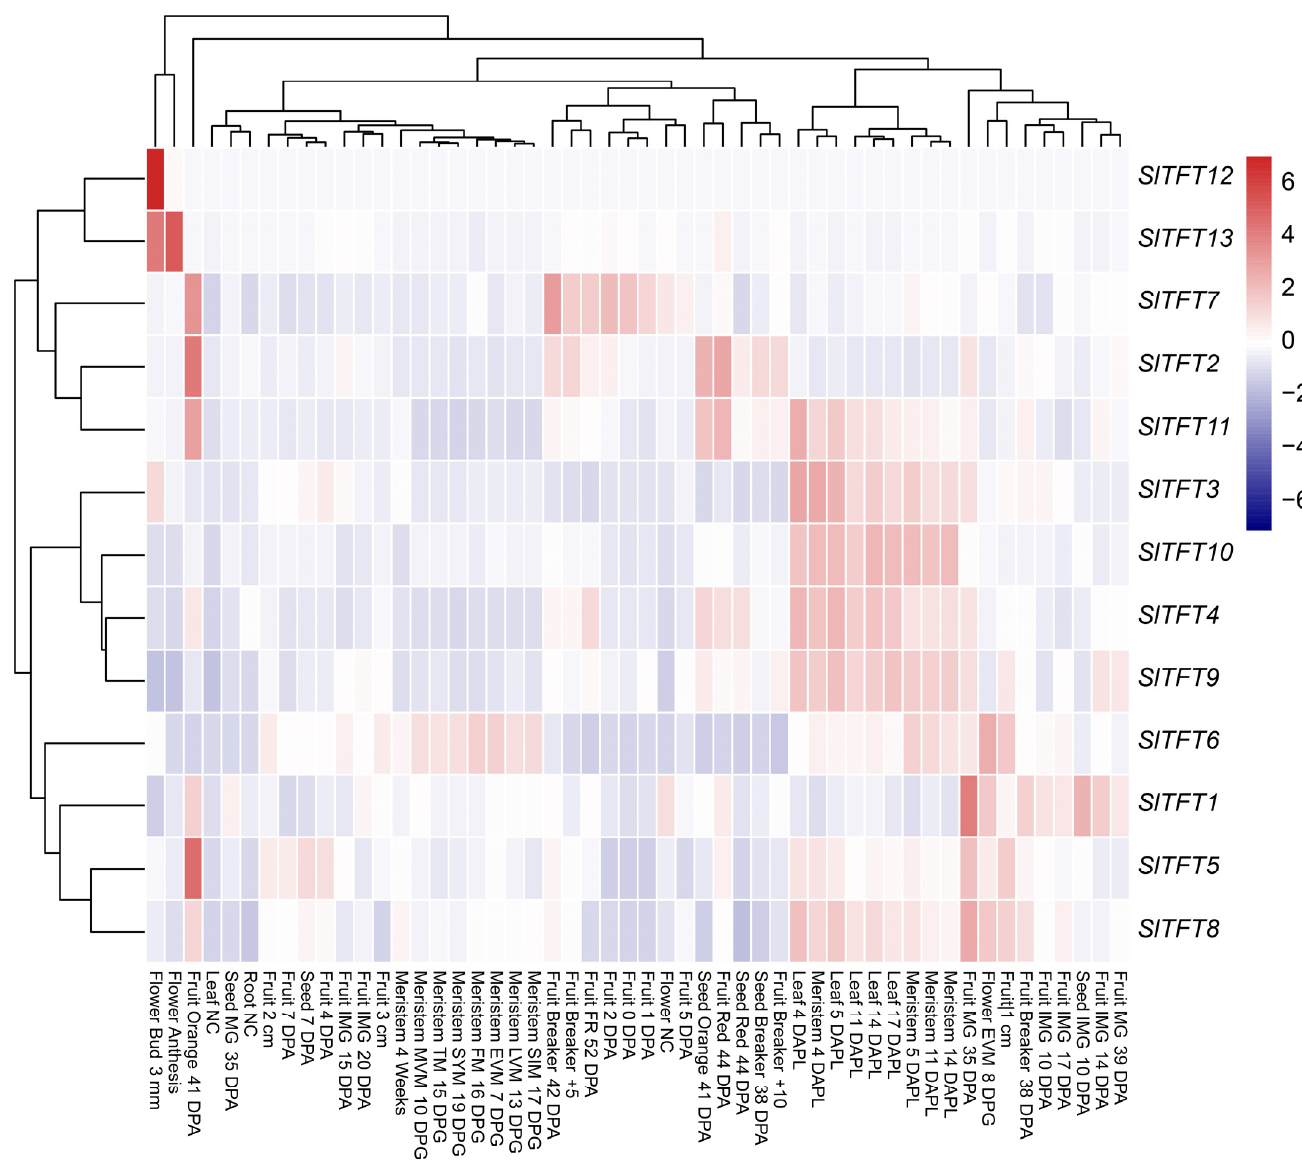
Figure 7. Clustering heat map of the expression patterns of SlTFTs in various tissues. The top of the figure indicates the hierarchical clustering results, and the bottom indicates the seeds, roots, meristematic tissues, leaves, flowers, and fruits at different periods in cultivated tomatoes. The left side of the horizontal coordinate shows the hierarchical clustering results, and the right side shows the expression patterns of all 13 SlTFTs . The gradient from blue to red indicates the expression from low to high.